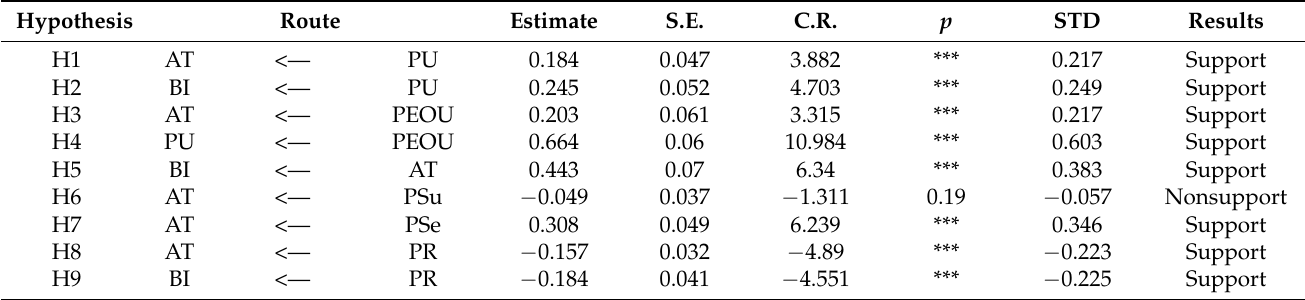
Table 9. Path analysis.